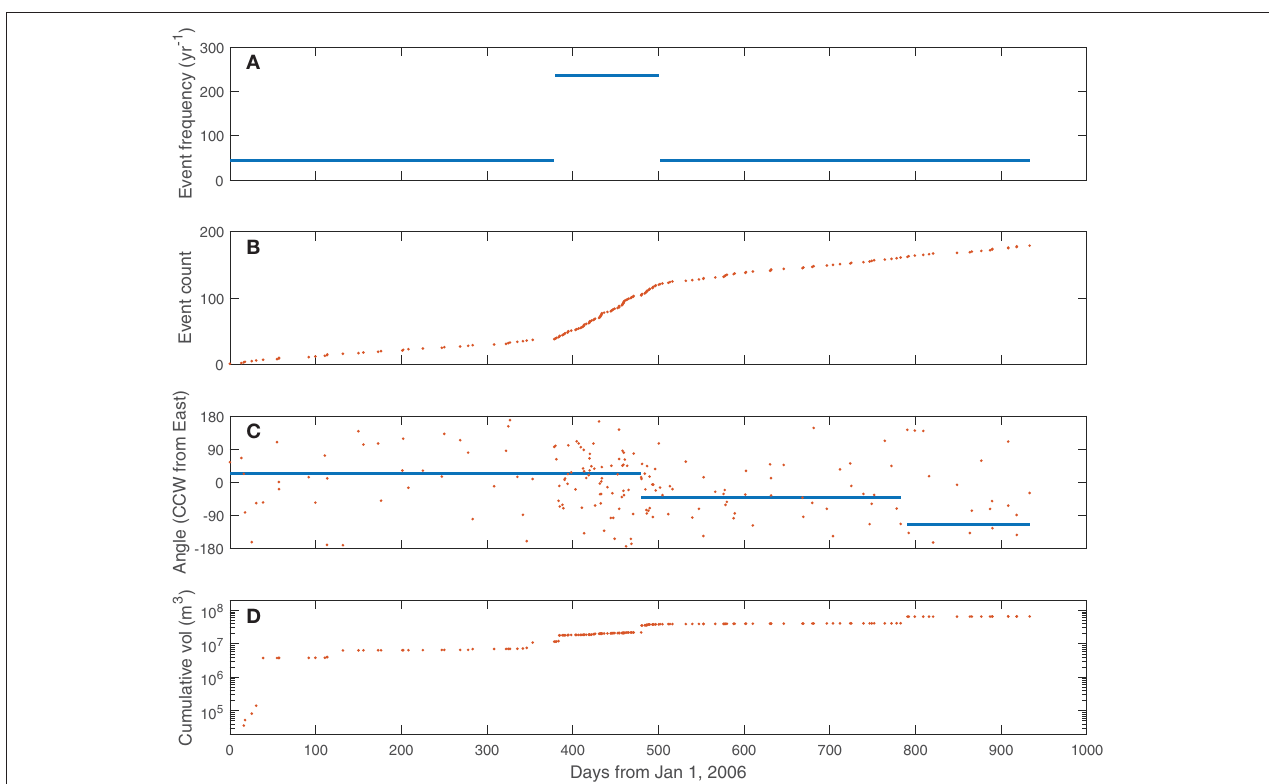
FIGURE 13 | One posterior draw of simulated forecast PDC activity for the period from 1 st January 2006 to 1 st August 2008 (943 days), forecast using prior data. Top panel (A) shows expected frequency λ ( t ) of PDC events. Second panel (B) shows cumulative event counts. Third panel (C) shows forecast central directions as solid blue curve and individual PDC events as red dots. Bottom panel (D) shows cumulative